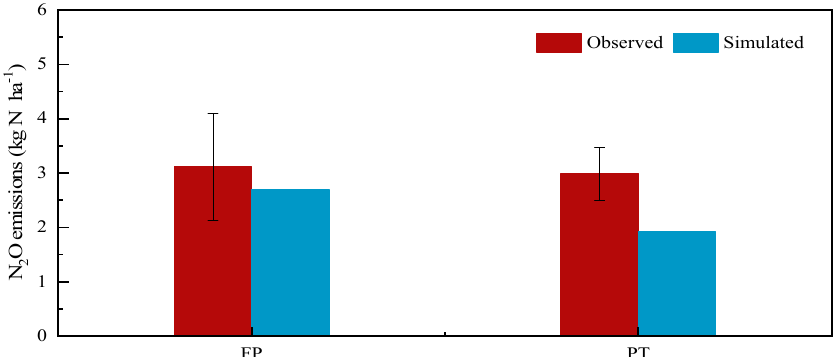
Figure 3. The simulated and observed values of total N 2 O emissions in 2016. FP represents farmers’ conventional practice; PT represents optimal practice.